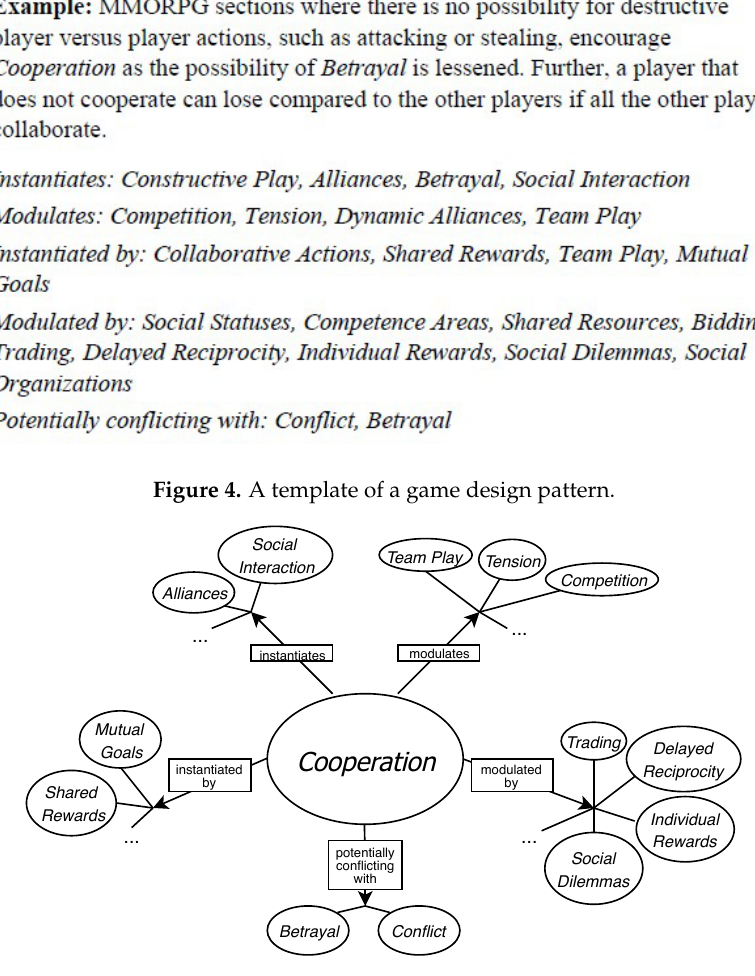
Figure 5. A diagram of the Co-operation pattern and its relationships with other patterns. Only selected patterns are depicted, those that do not appear in the figure are indicated by